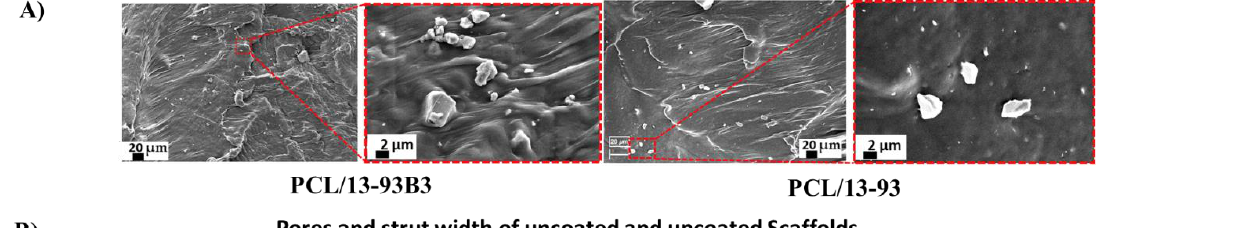
Table 3. Porosity values of PCL and PCL/BG composite scaffolds before and after coating.